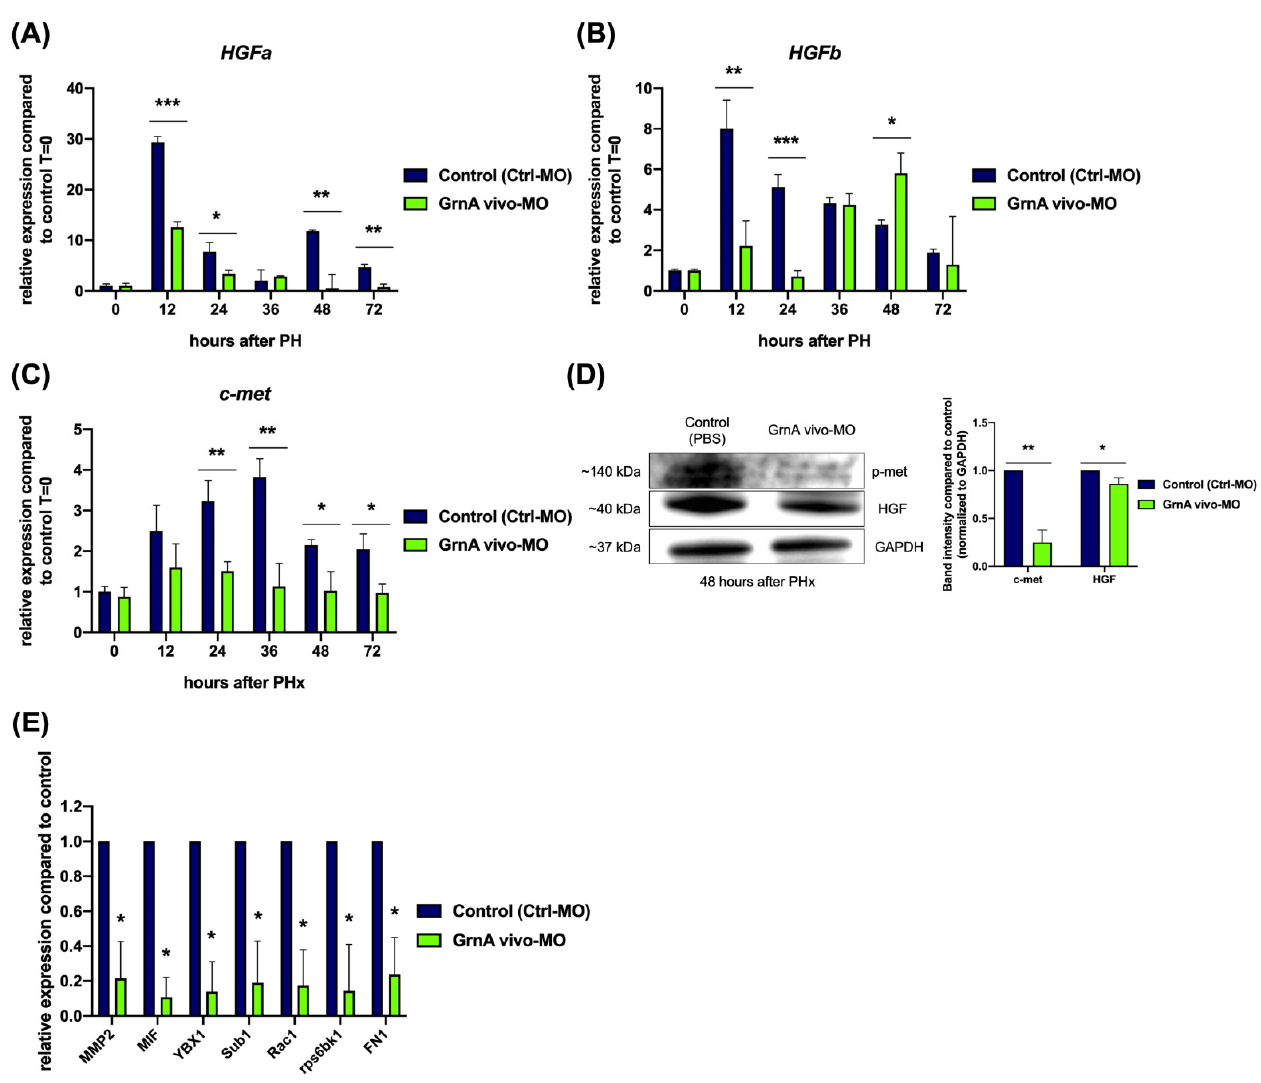
Figure 5. Knockdown of GrnA decreased the expression of HGF/c-met axis in hepatectomized zebrafish. Quantitative PCR analysis of zebrafish HGF paralogs, ( A ) HGFa and ( B ) HGFb , as well as the HGF-specific receptor, ( C ) c-met , in control and GrnA morphant zebrafish after PHx. The relative expression levels compared to control group at 0 h after PHx are presented as mean ± SD. EF1a served as the internal control. ( D ) Protein levels of p-met, HGF, and GAPDH were examined by Western blot analysis at 48 h after PHx. The levels of p-met and HGF proteins were normalized to GAPDH protein levels and then compared to control group. The fold change compared to controls is presented as mean ± SD. ( E ) Quantitative PCR analysis of c-met upstream signaling-related genes, including MMP2 , MIF , and YBX1 , and c-met downstream signaling-related genes, including Sub1 , Rac1 , rps6kb1 , and Fn1 . The relative expression levels compared to control group are presented as mean ± SD. EF1a served as the internal control. Significance was set at * p < 0.05, ** p < 0.01, *** p < 0.001, as determined by t -test; PHx, partial hepatectomy; p-met,